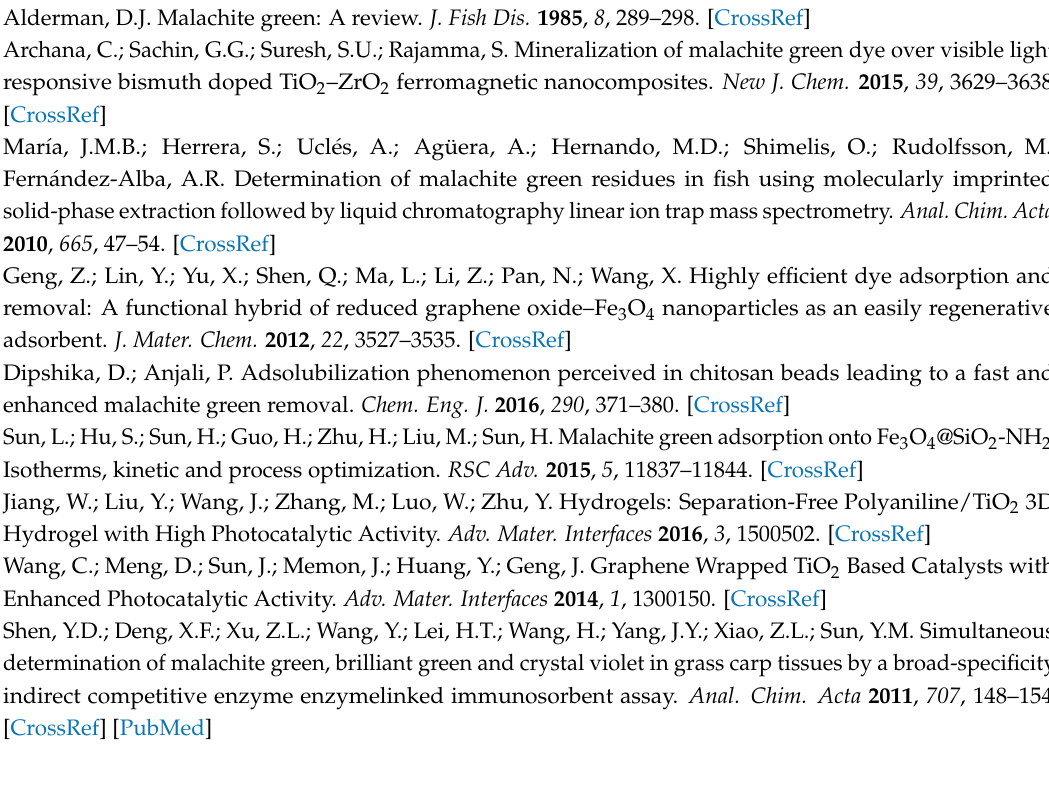
Figure S1: EDS spectrum of ZnO/RGO@Ni Foam, Figure S2: (a) The photocatalytic degradation process of MB (10 mg/L) in the presence of ZnO/RGO@NF under visible light irradiation; (b) MB degradation (%) at different irradiation time with or without catalyst under visible light irradiation, Equation (S1): Bragg’s law, Table S1: Comparison of photocatalytic activity of ZnO/RGO based photocatalysts for dyes degradation, Video S1: Under UV light irradiation the malachite green (10 mg L − 1 ) in seawater degraded by ZnO/RGO@NF in a continuous flow sea water